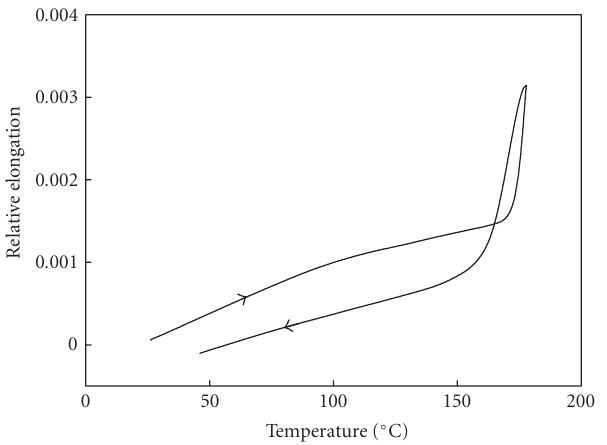
Figure 3: Temperature dependence of the relative elongation for Ni 53 . 6 Mn 27 . 1 Ga 19 . 3 alloy during the incomplete cycle with a stop at T = 177 ◦ C.